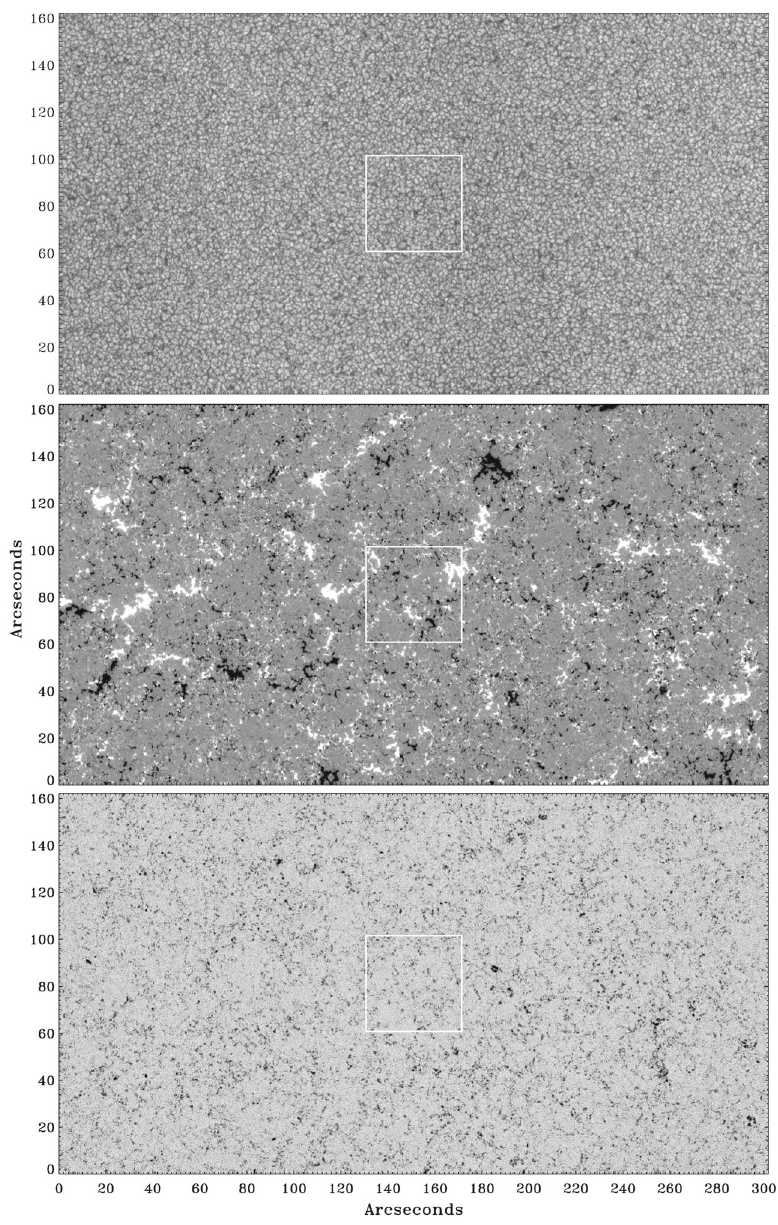
Fig. 1 Quiet Sun at disk center as observed by the Hinode spectropolarimeter on 10 March 2007 between 11:37 and 14:37 UT. The top panel shows a continuum intensity map at 630 nm. The other panels display thecorrespondingmapsoflongitudinalmagneticfluxdensity(middle)andtransversefluxdensity(bottom). TheywerederivedfromthecircularandlinearpolarizationsignalsobservedintheFe i 630nmlinepair.The gray scales saturate at ± 50 Mx cm − 2 and 200 Mx cm − 2 , respectively. Images reproduced with permission from Lites et al. (2008), copyright by